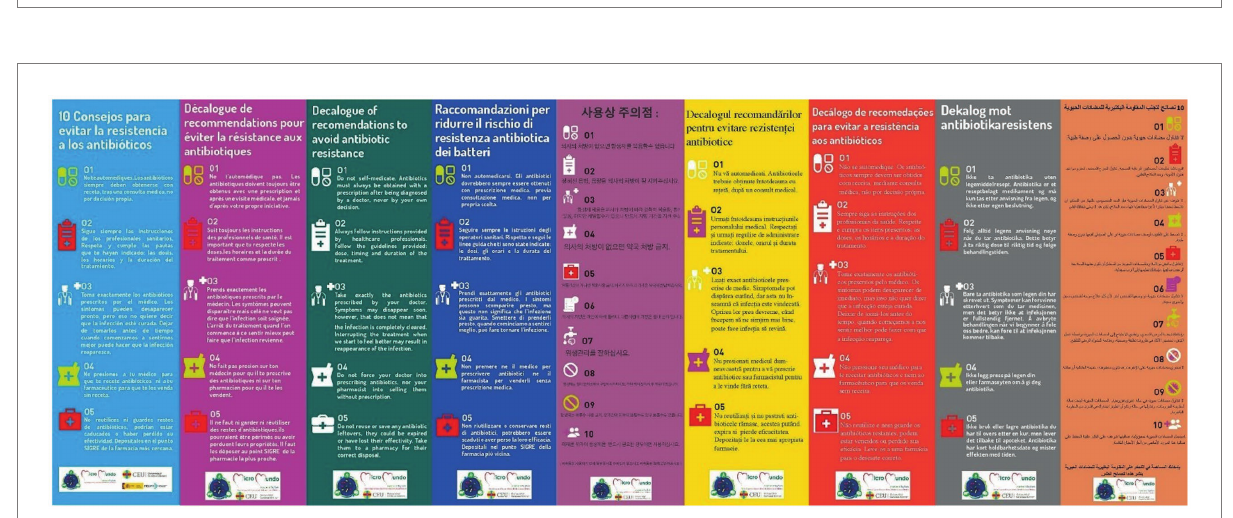
FIGURE 4 Infographics of the decalogue of recommendations to avoid antibiotic resistance in several languages. Bookmark